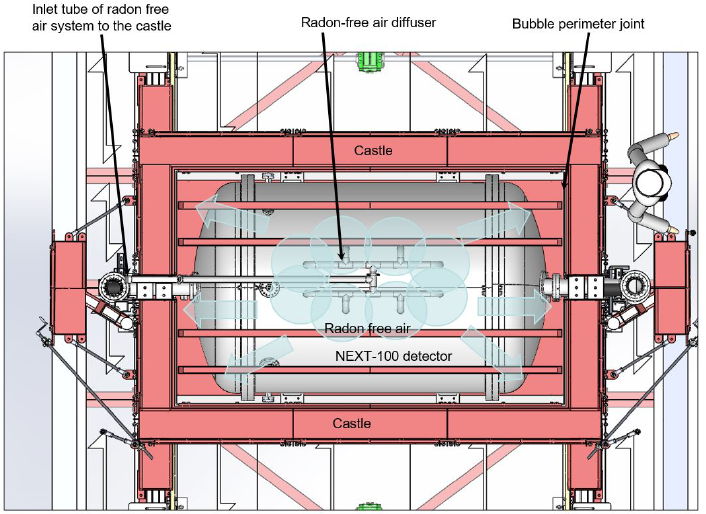
Figure 13. Top view of the closed Castle with a scheme of the distribution of the Rn-free air.